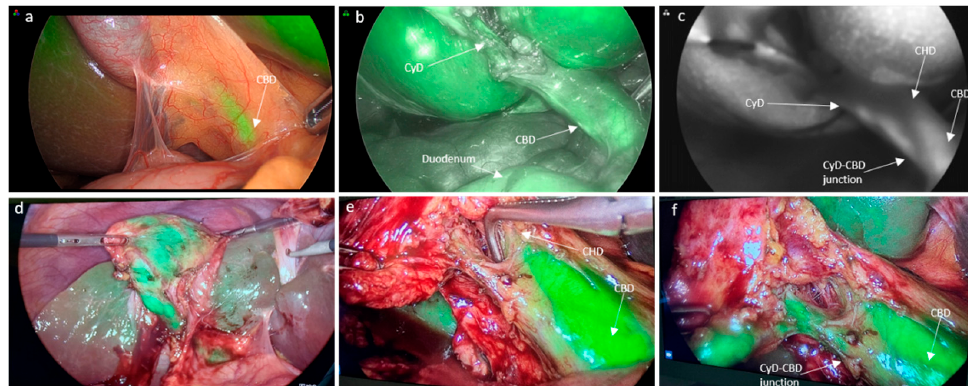
Figure 2. Intravenous ICG injection. ( a ) Initial view of ICG-cholangiography prior to dissection; ( b ) visualization of cystic duct after dissection; ( c ) view in ‘SPY’ mode; ( d ) clear delineation of the gallbladder; and ( e , f ) cystic and common bile duct with minimal liver fluorescence (CyD: cystic duct, CyA: cystic artery, CBD: common bile duct, CHD: common hepatic duct).